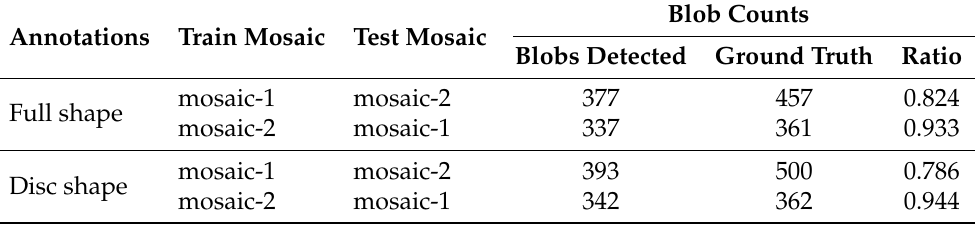
Table 6. Blob count results after post-processing predicted segmentation.